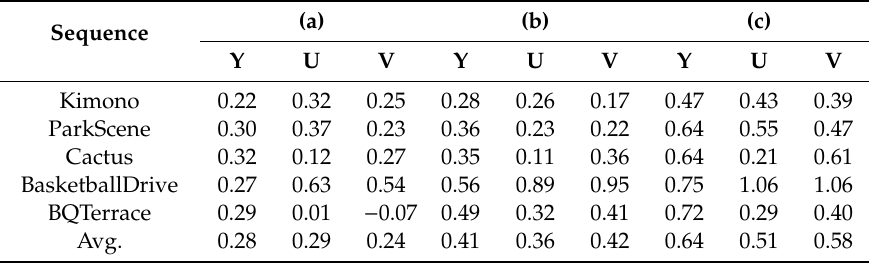
Table 7. Coding performance of (a) the original and horizontal reference sets, (b) the original and vertical reference sets, and (c) the original, horizontal, and vertical reference